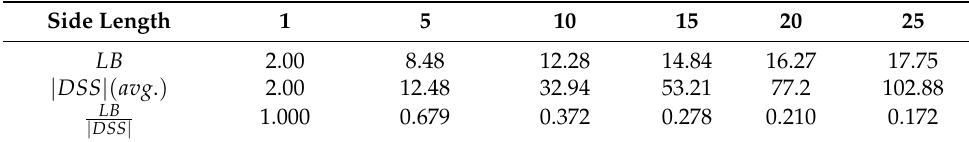
Table 2. Experimental results on light headed